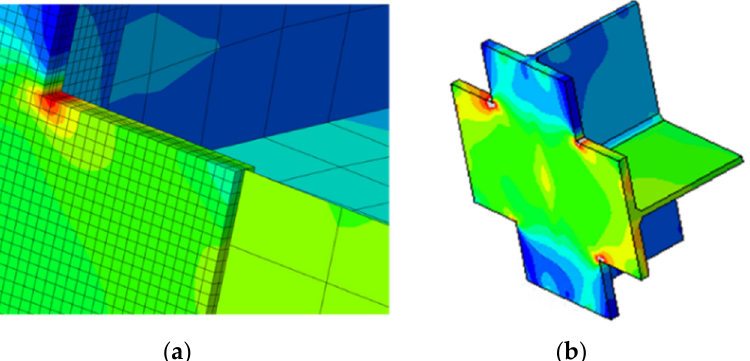
Figure 7. ( a ) A submodel embedded in gate model with mesh view; ( b ) 3D of submodel with contours from loading applied to the gate.